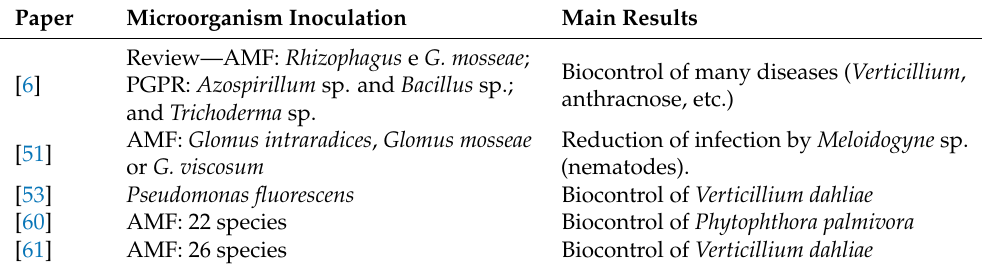
Table 2. Effects of microorganism inoculation on biocontrol of diseases and pests in olive trees.